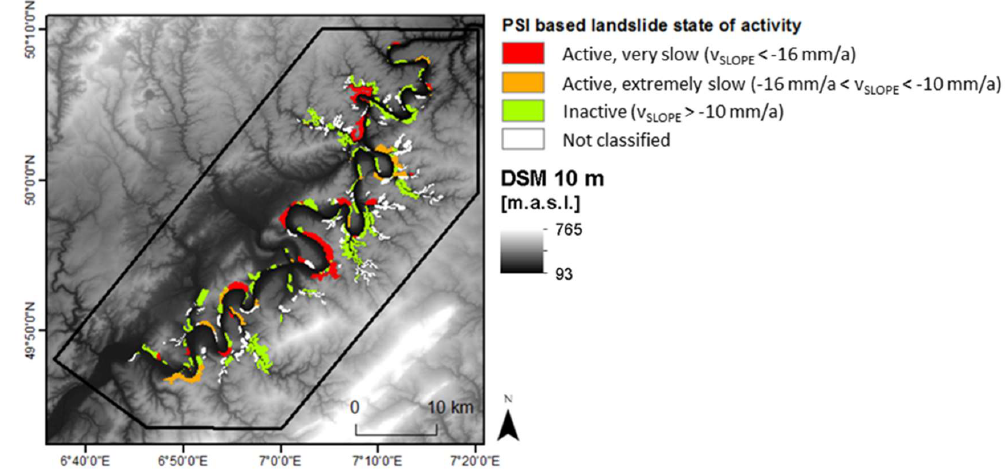
Figure 5. Result of the classification of the landslide state of activity based on Sentinel-1 PSI data. A DEM © GeoBasis-DE / BKG 2018 [19] serves as background.